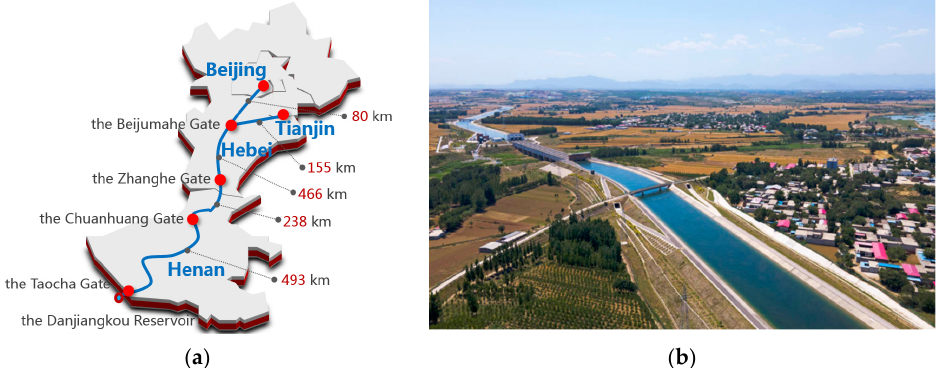
Figure 1. Main canal of the middle route of the South-to-North Water Diversion Project: ( a ) general layout and ( b ) canal and crossing water-conveyance structures.